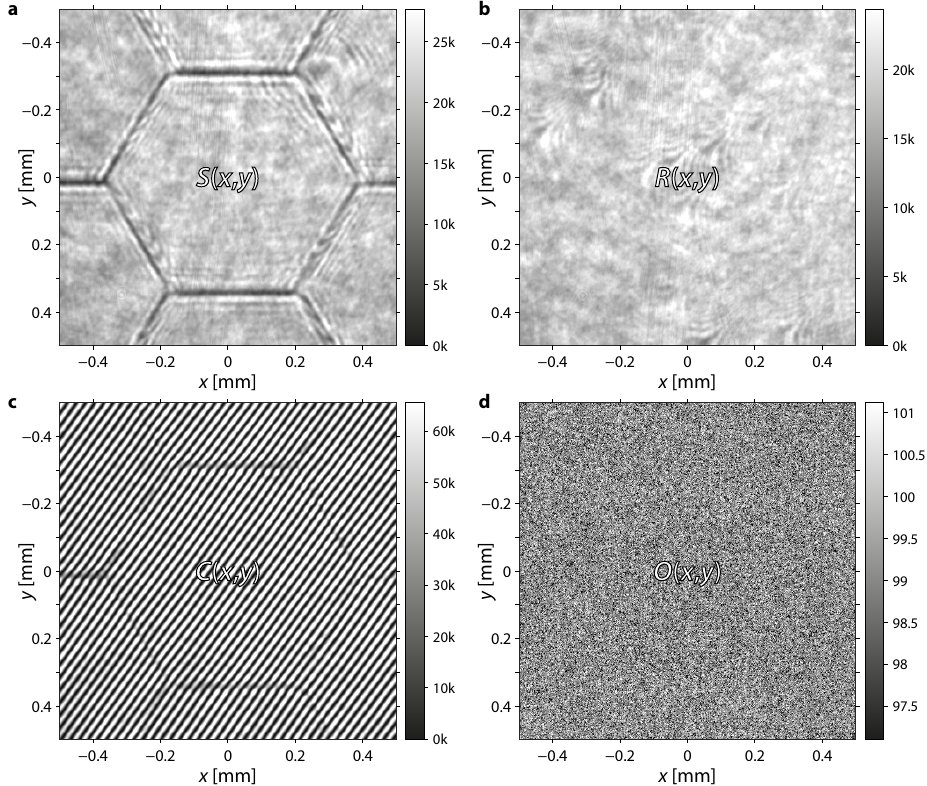
Figure 2. Illustration of the measured intensity images: ( a ) intensity reflected from the deformable mirror; ( b ) intensity reflected from the reference mirror; ( c ) interference pattern from both mirrors; ( d ) offset of the camera